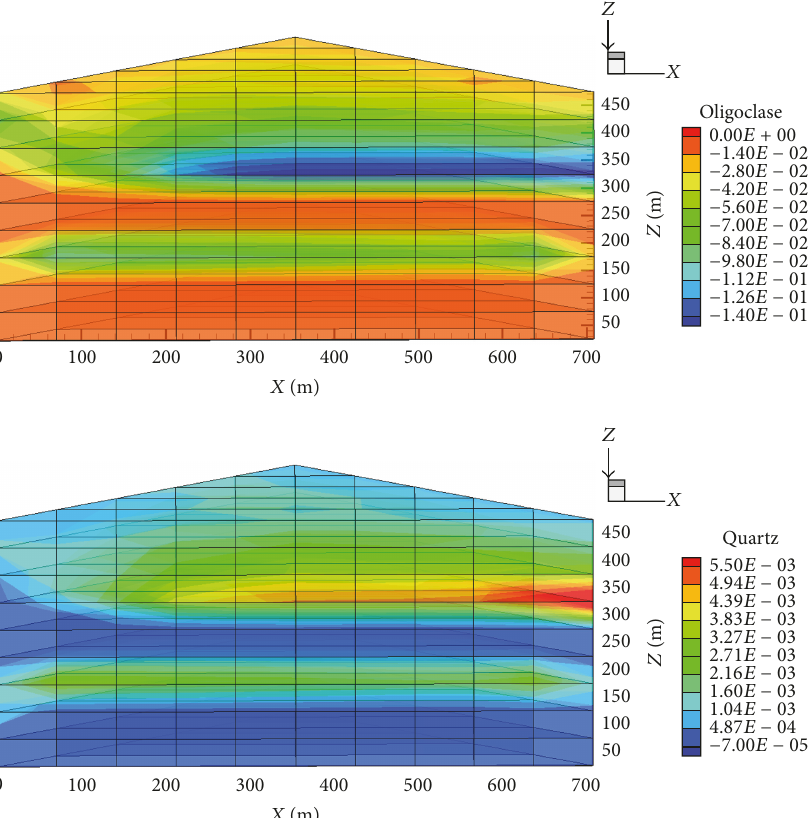
Figure 5: Simulated 3D profiles of changes of mineral abundance (in volume fraction) for primary minerals (oligoclase and quartz) after 30-year injection of scCO 2 as a working